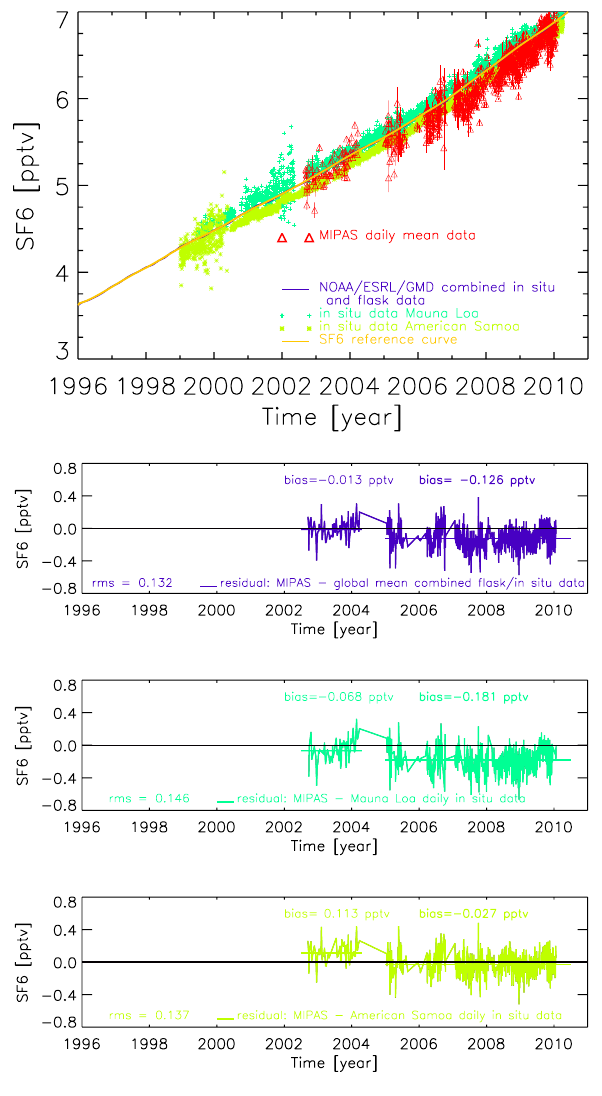
Fig. 2. Top panel: tropical upper tropospheric time series of SF 6 from MIPAS observations (daily zonal averages between 17.5 ◦ S and 17.5 ◦ N and 9 to 15km altitude; red triangles) together with monthly global mean combined flask and in situ data (violet line, hard to see), Mauna Loa Observatory daily mean in situ observa- tions (dark green crosses), and American Samoa daily mean in situ observations (light green asterisks). The solid orange curve presents the SF 6 tropical reference curve derived as described in the text. Bottom panel: daily mean deviations between MIPAS tropical up- per tropospheric SF 6 volume mixing ratios and the monthly global mean combined flask and in situ data set (top), Mauna Loa Observa- tory daily mean in situ observations (middle), and American Samoa daily mean in situ observations (bottom). Numbers in the panels provide the rms over the whole MIPAS observation period, and the mean bias between MIPAS SF 6 vmr and the respective flask and/or in situ observations for the periods 2002 to 2004 and 2005 to 2010,